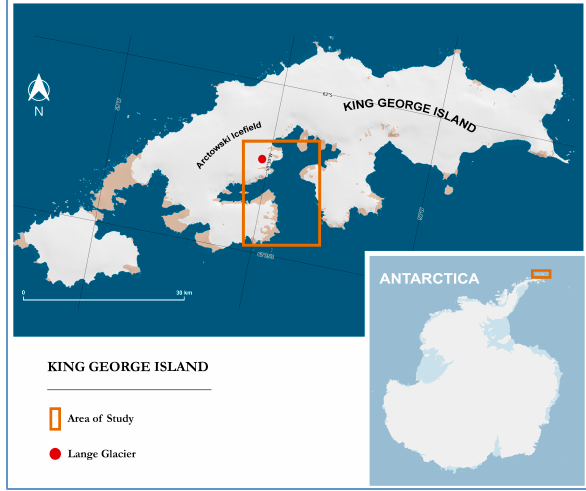
Figure 1. Location of Lange glacier: Left King George Island and red point Lange